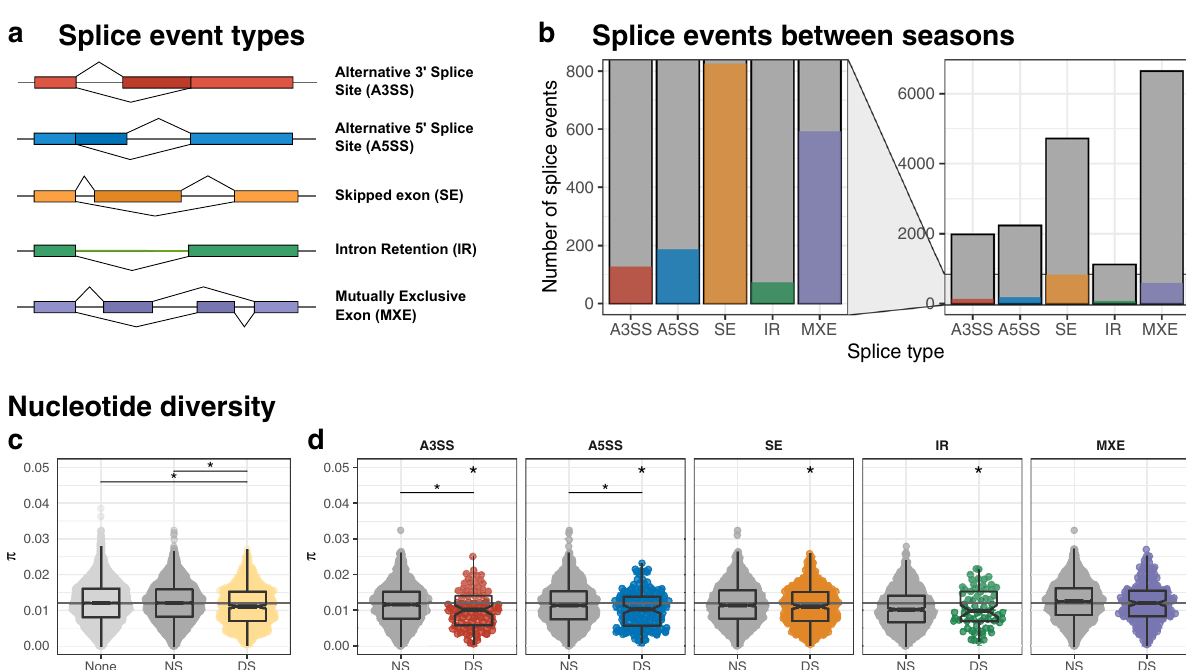
for each event type. The various splice event types (Fig. 4a) that contribute to alternative splicing differ both in how they are regulated ( cis vs . trans ) and in their potential to result in nonsense mediated decay of non-functional mRNAs versus functional protein isoforms 49,58 . Based on our previous results, we expected genes containing events that are differentially spliced between seasonal morphs to experience stronger selection and to have lower genetic variation. Further, we expected that this signal would be strongest for splice events that are more likely to be cis - regulated, including alternative 3 ′ and 5 ′ splice sites (A3SS, A5SS) and intron retention (IR).